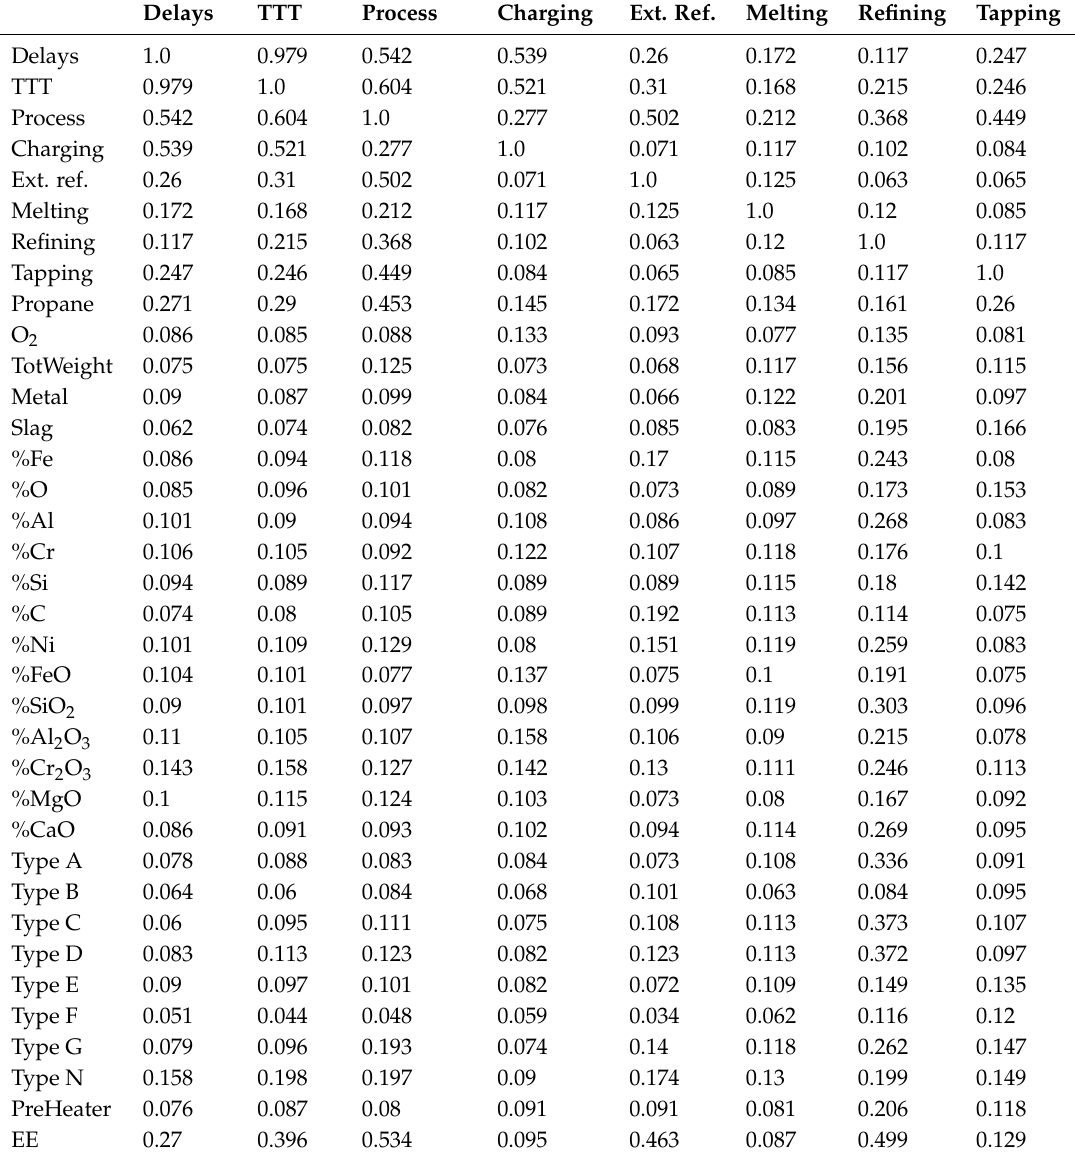
Table A5. Variable-variable distance correlation for the test